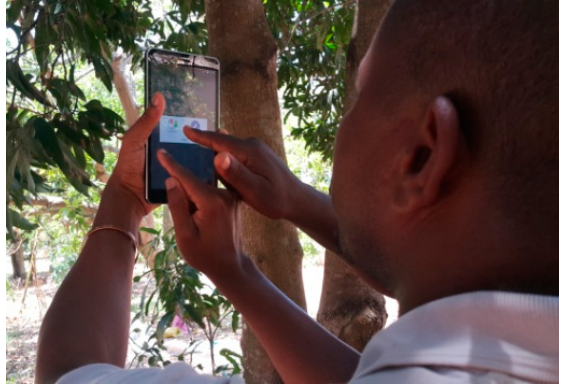
Figure 7. Using the mobile application to collect alphanumeric and geographic information.